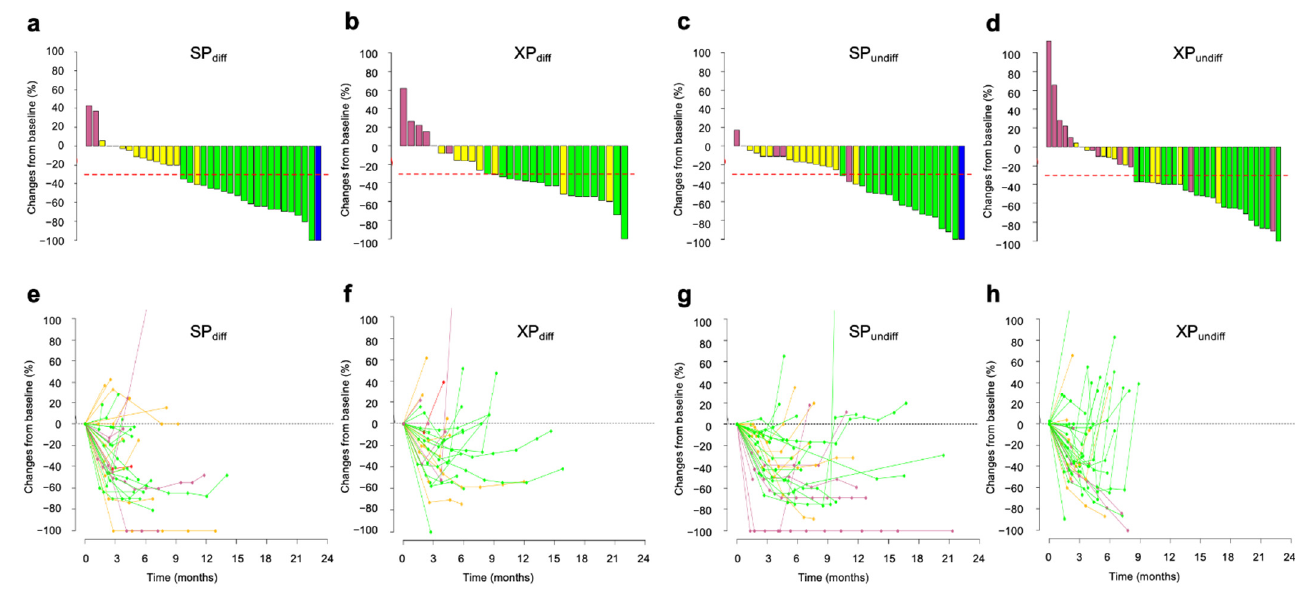
Figure 4. Changes in tumor size according to tumor histology during treatment with SP or XP. ( a – d ) Best change from baseline in the sum of the longest target lesion diameters for differentiated tumors (diff, a , b ) or undifferentiated tumors (undiff, c , d ) in each patient treated with SP ( a , c ) or XP ( b , d ). Best responses are color-coded: blue, CR; green, PR; yellow, SD; pink, PD. Red dashed lines indicate tumor shrinkage of 30%. ( e – h ) Time course of the percentage change in the sum of the longest target lesion diameters from baseline for differentiated tumors (diff, e , f ) or undifferentiated tumors (undiff, g , h ) in each patient treated with SP ( e , g ) or XP ( f , h ). Finally, we performed subgroup analysis for PFS and OS according to tumor histology (differentiated type vs. undifferentiated type) and tumor shrinkage (tumor size reduction of ≥ 30% from baseline vs. <30%) (Figure 5). Although both PFS and OS tended to be better for SP than for XP in most subgroups, a significant benefit of SP versus XP was apparent only for OS in patients with differentiated tumors and a tumor size reduction of ≥ 30% (23.7 months [95% CI, 13.2–not available] vs. 11.7 months [95% CI, 7.8–19.6 months]; HR of 0.339 [95% CI, 0.163–0.705]; interaction p = 0.003; Supplementary Figure S4), suggesting that deeper tumor shrinkage induced by SP compared with XP contributed to prolongation of OS for patients with differentiated tumors.